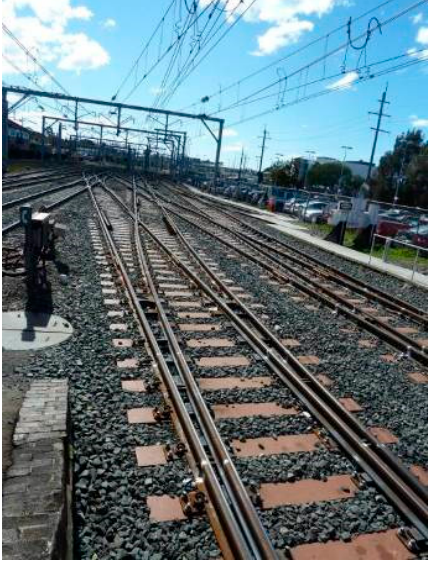
Figure 4. General condition of the double slips.